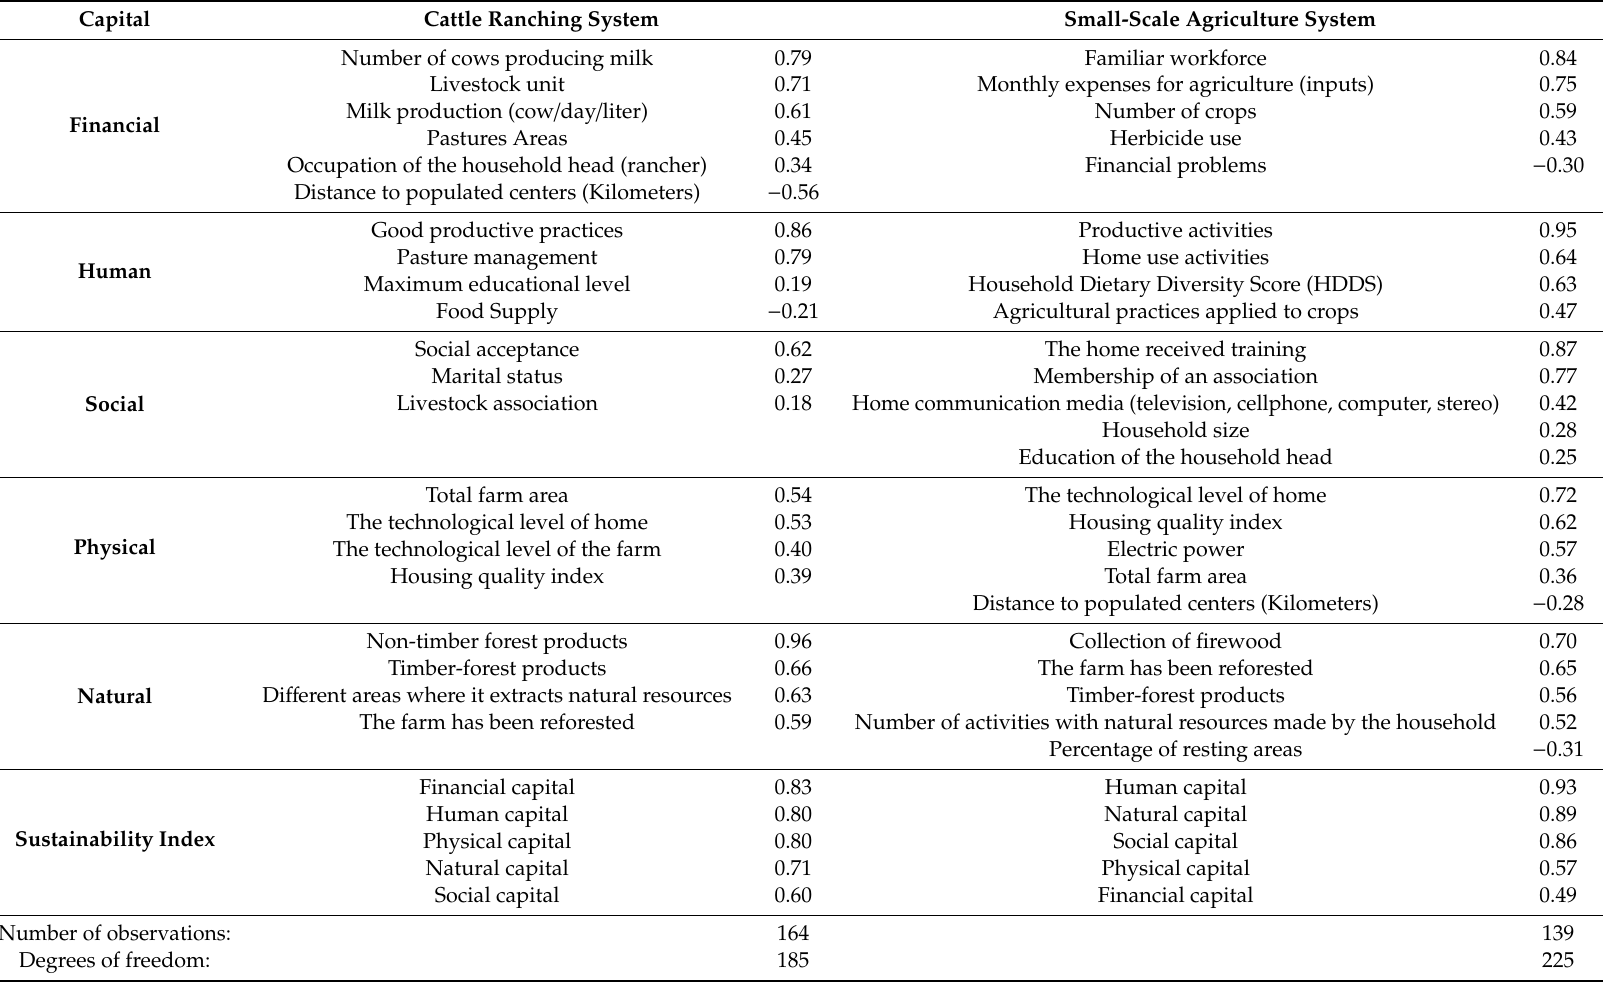
Table 3. Standardized coe ffi cients of confirmatory factor analysis for sustainable livelihood, with all variables having significant variations among farms ( p <